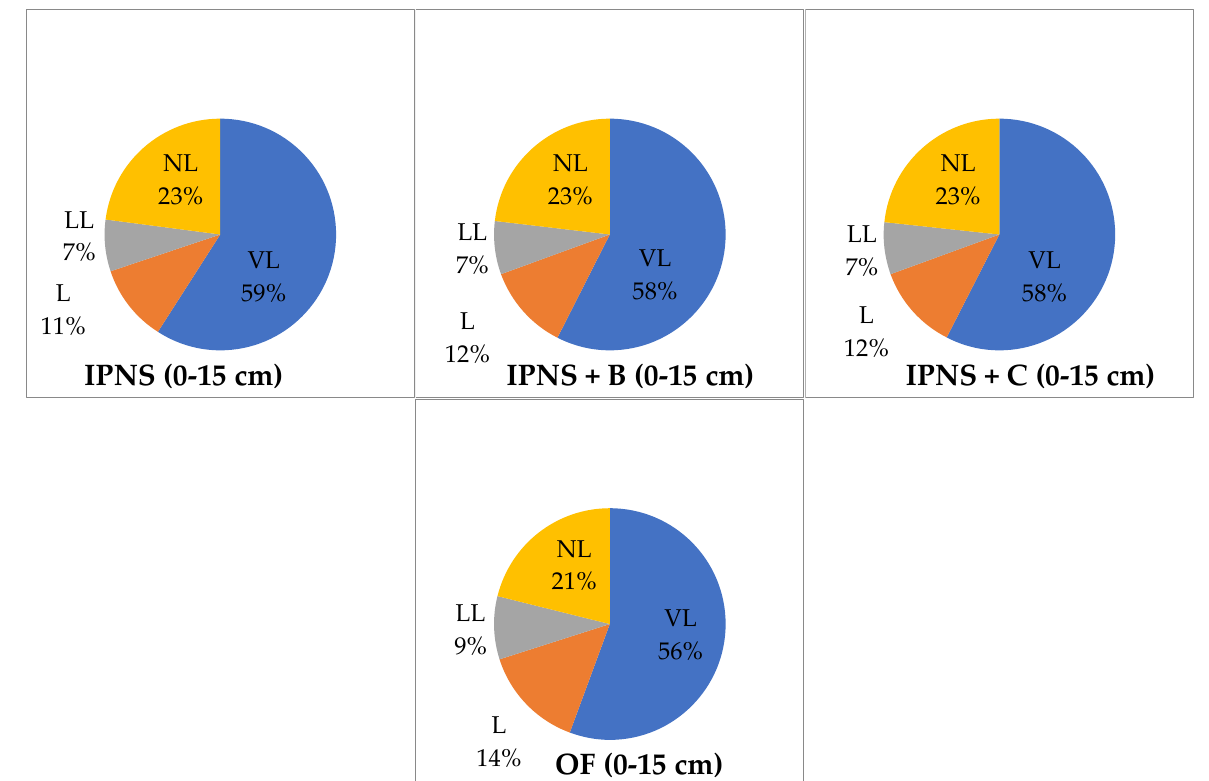
Figure 8. Effect of nutrient management on C fractions contribution (0–15 cm).